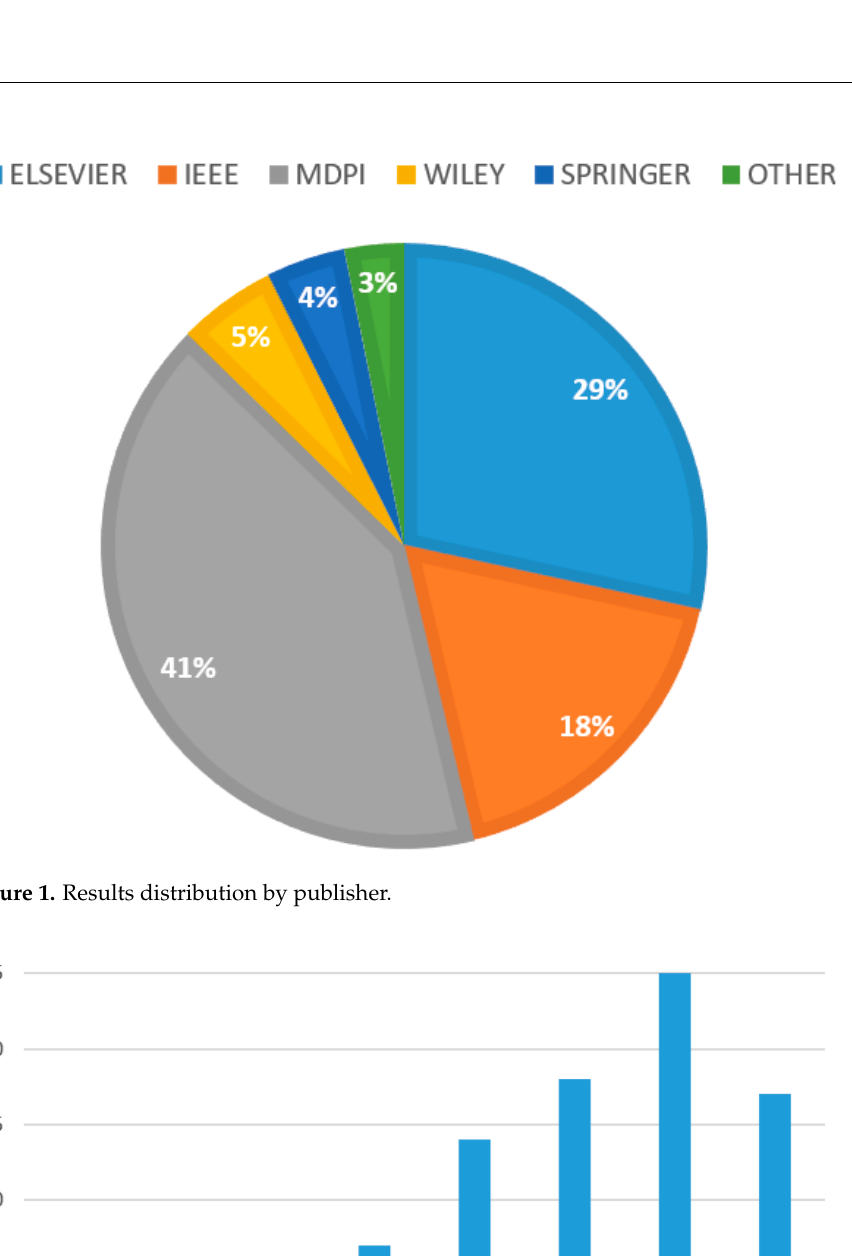
Figure 2. Results distribution by publishing year.